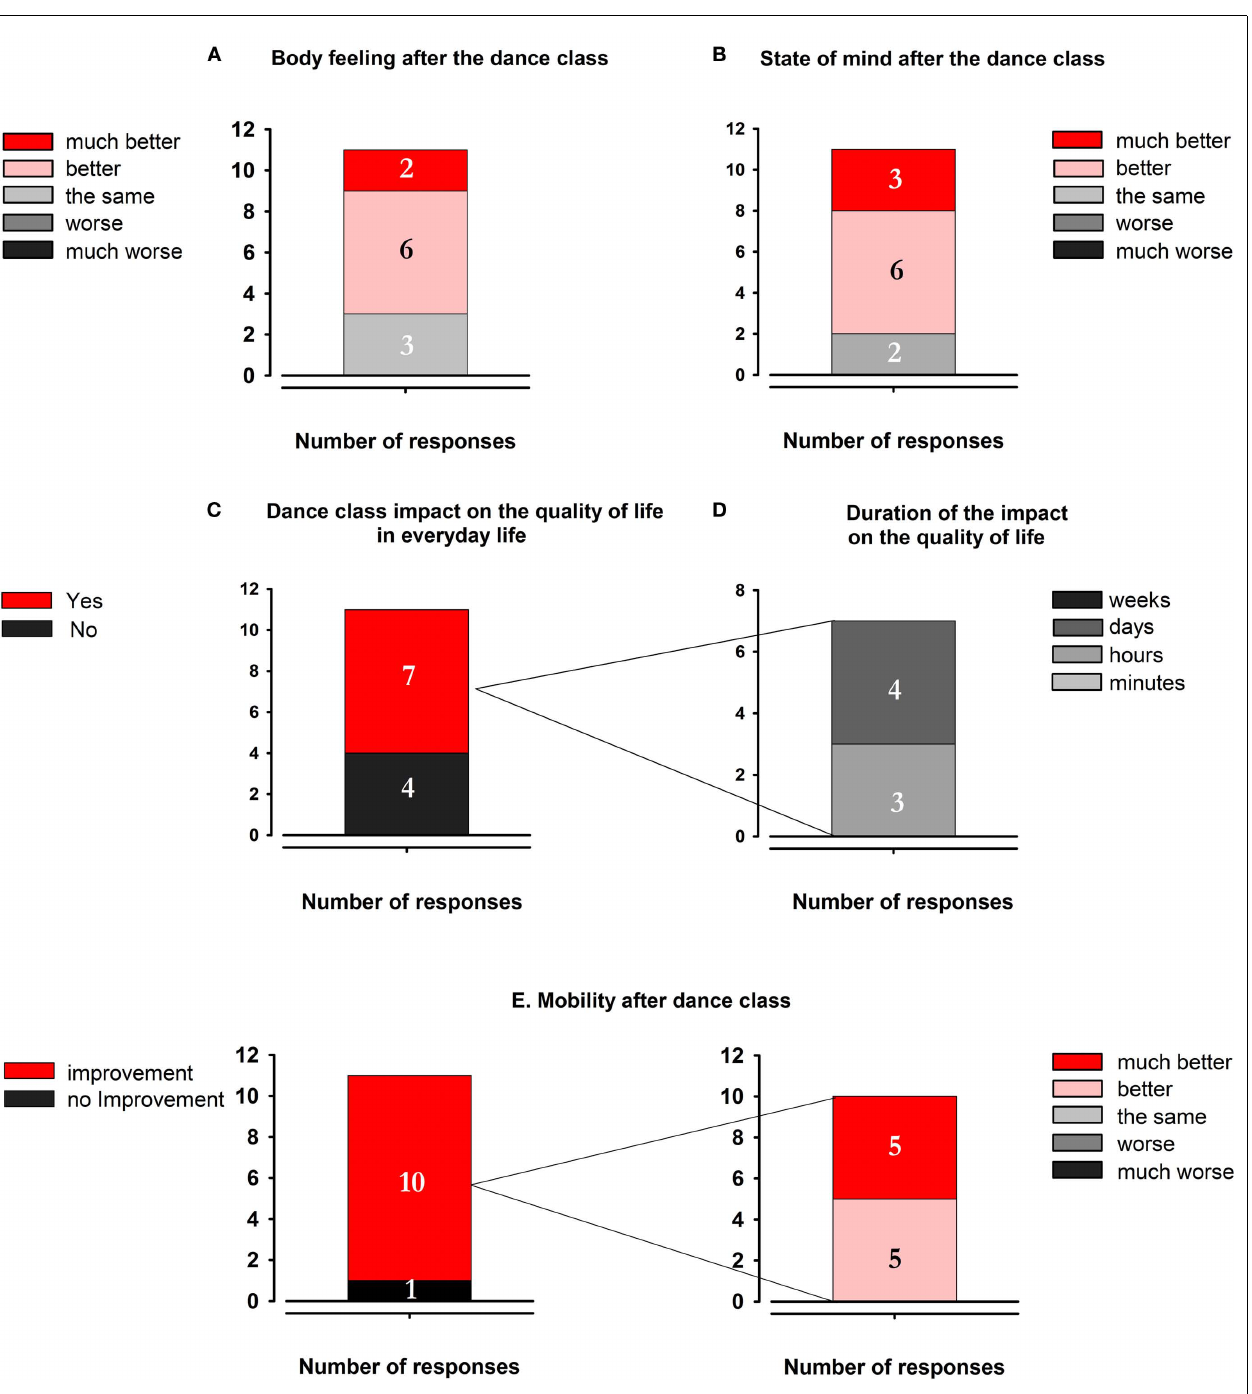
FIGURE 4 | Results of the modified questionnaire ofWestheimer (2008). (A) Body feeling after the dance class. (B) State of mind after the dance class. “Moodenhancement,satisfaction”;“Thedanceclassisthehigh- lightof theweek”;“Itfeelsgoodtobewithmanypeople.Otherwise I live in isolation.”; “The movement, social contacts, music inter- pretation”; “Dancing is my great passion that I can enjoy during the dance class.”;“I feel more flexible after dance class.”;“Fun